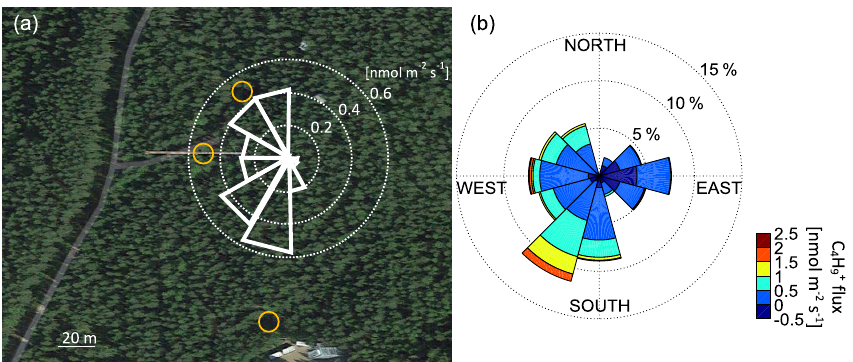
Figure 11. On the left side the average C 4 H + flux is shown (data of the whole campaign) in white. The orange circles illustrate the locations 9 of the aerosol instruments, which use butanol. The average fluxes from north to south-southeast are under 0.05nmolm − 2 s − 1 . The map was taken from Google Maps (Image ©2016 Google; map data ©2016 Google). The wind rose of the C 4 H + fluxes is shown on the 9